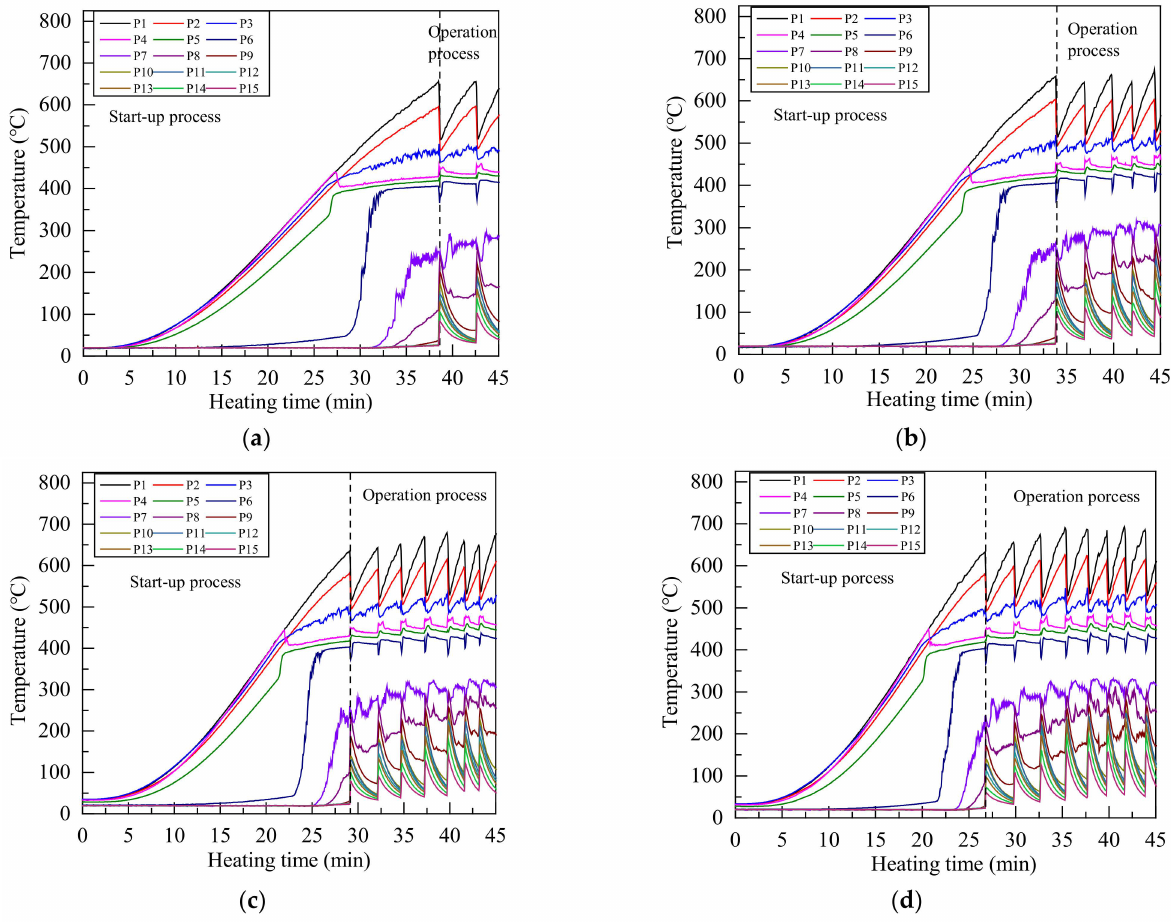
Figure 5. Temperature distribution of Na-K alloy heat pipe under heating power of ( a ) 800 W; ( b ) 1000 W; ( c ) 1200 W; ( d ) 1400